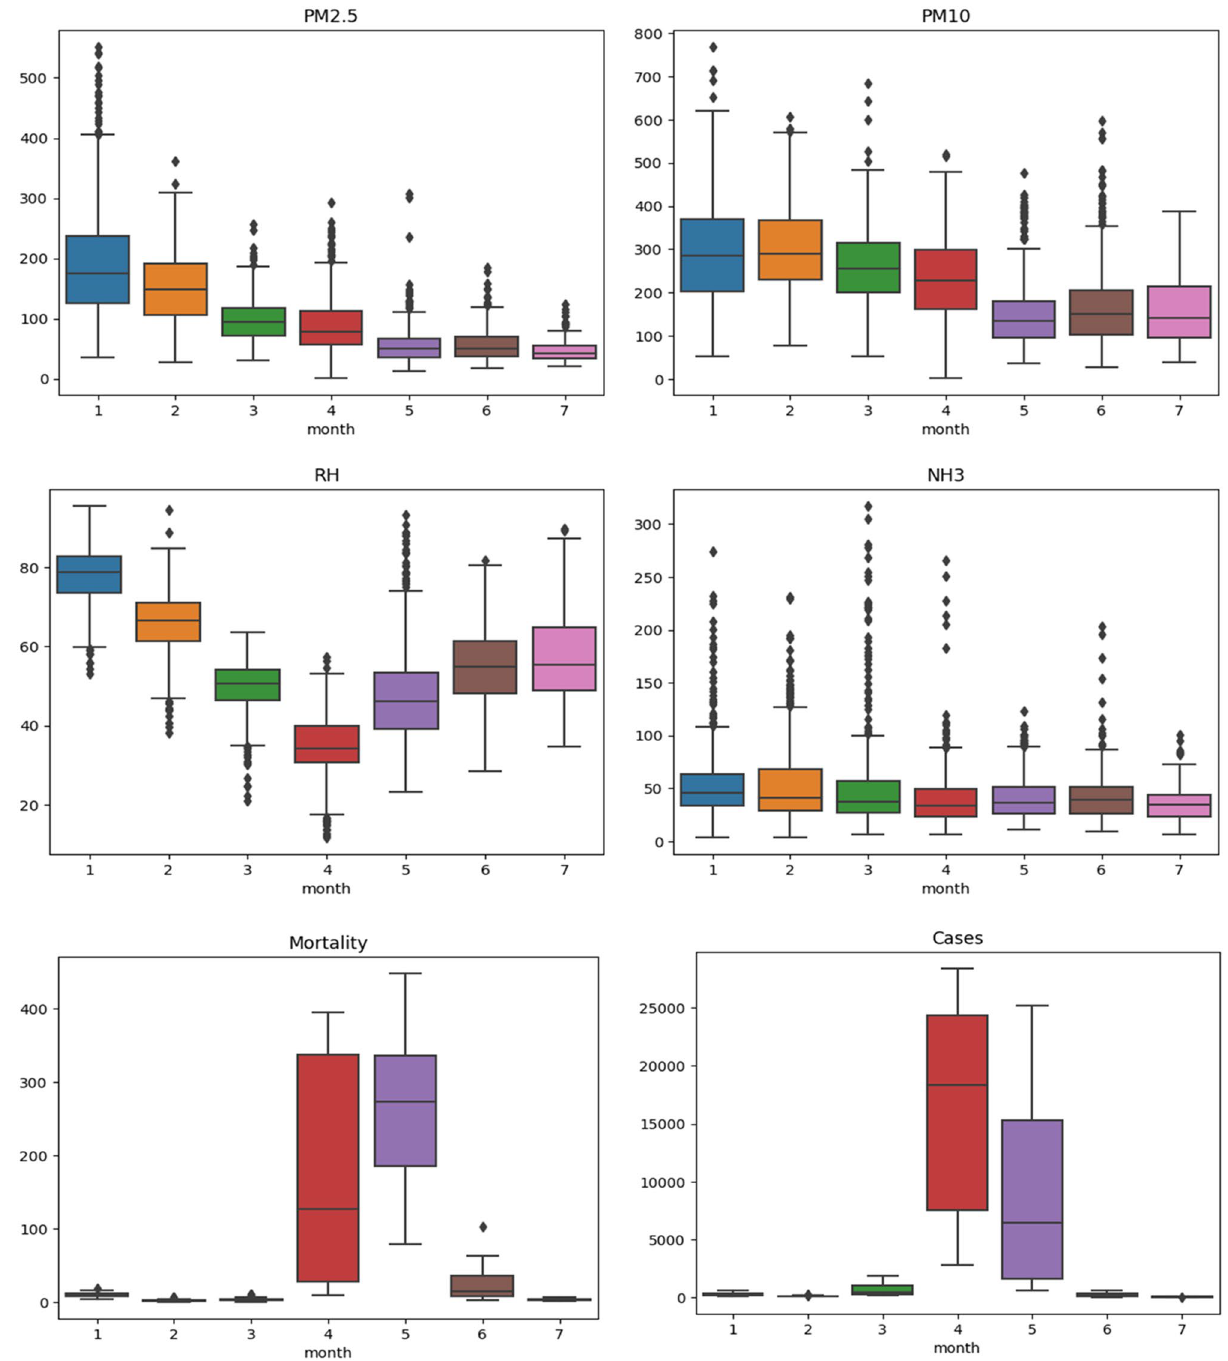
Figure 4. Box plot for month-wise distribution of variables including environmental risk factors and COVID- 19